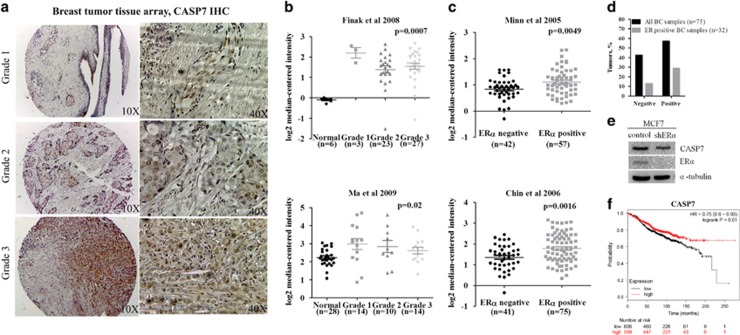
High levels of CASP7 expression in breast tumor grades and correlation with estrogen receptor status with pathological implication. (a) Representative immunohistochemistry images for CASP7 staining in breast carcinoma tissue microarray (TMA) with various tumor grades as specified. (b) Positive correlation between CASP7 mRNA expression and tumor stages in two independent breast carcinoma data sets extracted from Oncomine (Finak et al.25; Ma et al.26). (c) Positive correlation between CASP7 expression and estrogen receptor status in two independent data sets (Minn et al.29; Chin et al.28). (d) Percentage of CASP7 staining in breast carcinoma TMA samples. (e) Western blots showing efficient knockdown of ERα and reduction of CASP7 in MCF7 cells. (f) KM survival curve for relapse-free survival in breast cancer patients following combinatorial endocrine therapy. High expression of CASP7 correlated with better prognosis.